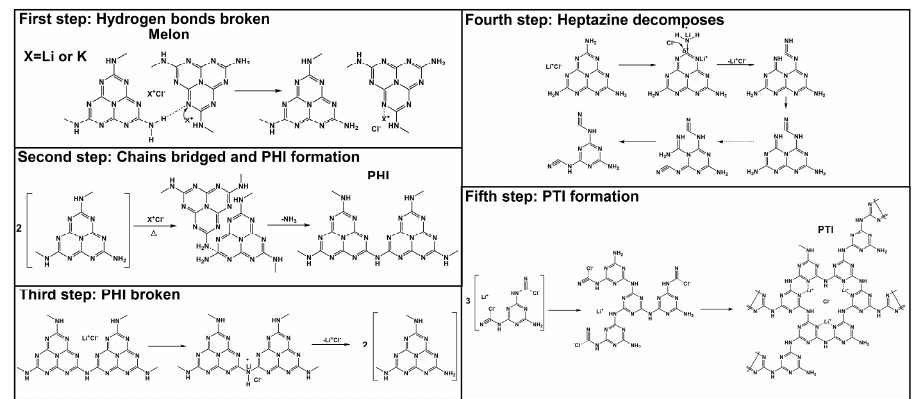
which exhibited a larger particle size than PHI, the speci fi c surface area was reduced from PHI to PTI.